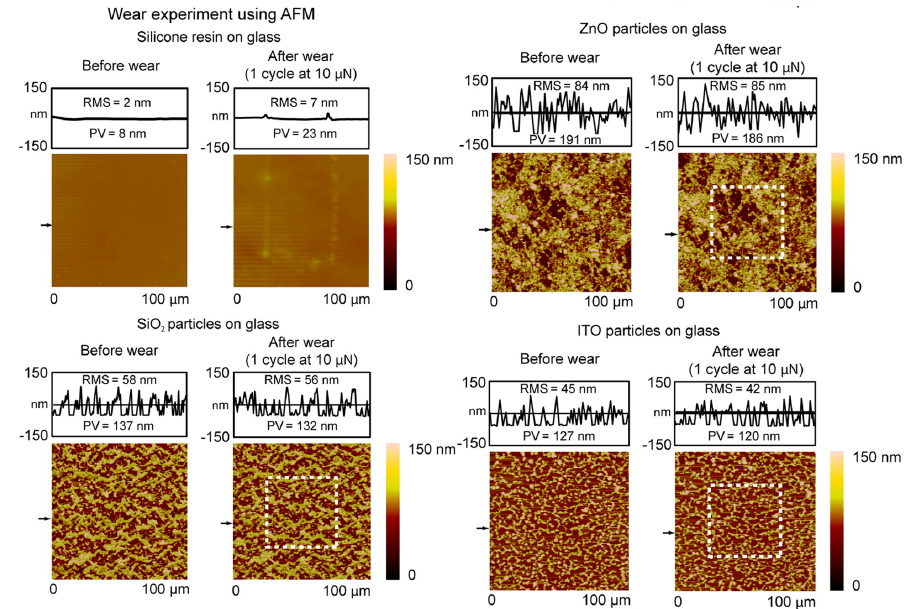
Figure 7. Surface height maps and sample surface profiles (locations indicated by arrows) before and after AFM wear experiment using 15 μ m radius borosilicate ball at load of 10 μ N for glass samples with silicone resin alone, SiO 2 nanoparticles, ZnO nanoparticles, and ITO nanoparticles. rms roughness and PV distance values for surface profiles are displayed within surface profile boxes. Results shown are typical for all substrates [33].